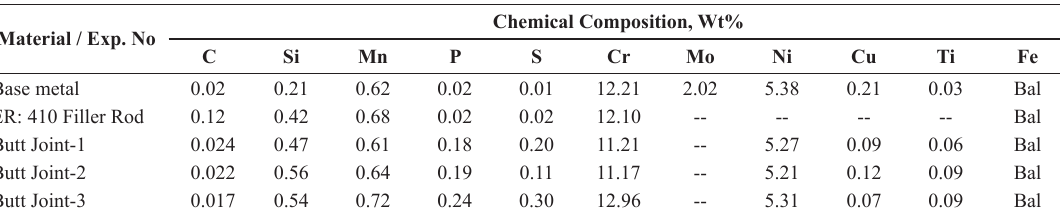
But, there was very limited visible literature on welding of